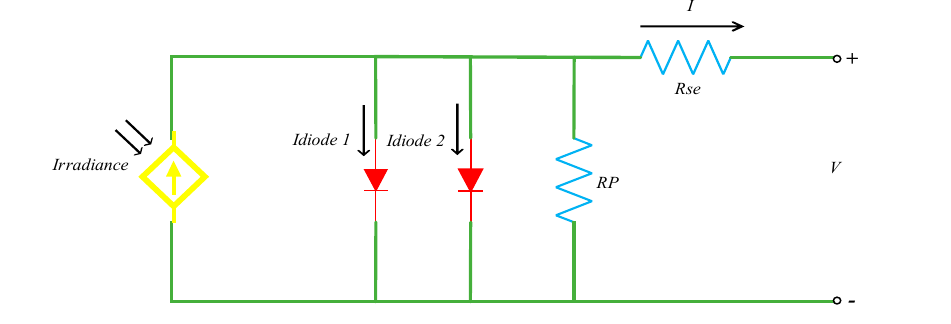
Figure 2. Electrical equivalent model of DDM.